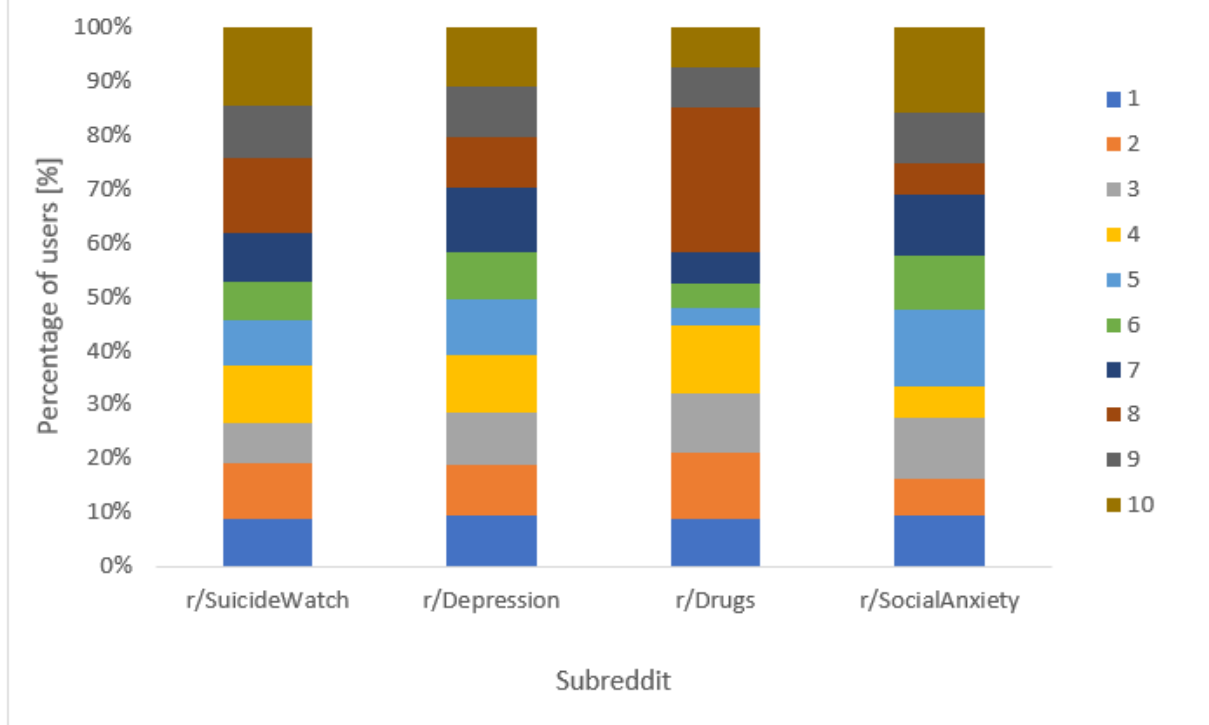
Figure 2. Percentage of people in each of the clusters shown in Table 2 who posted in specific subreddits. The partitions are statistically significant (chi-square test) only for r/Drugs ( P